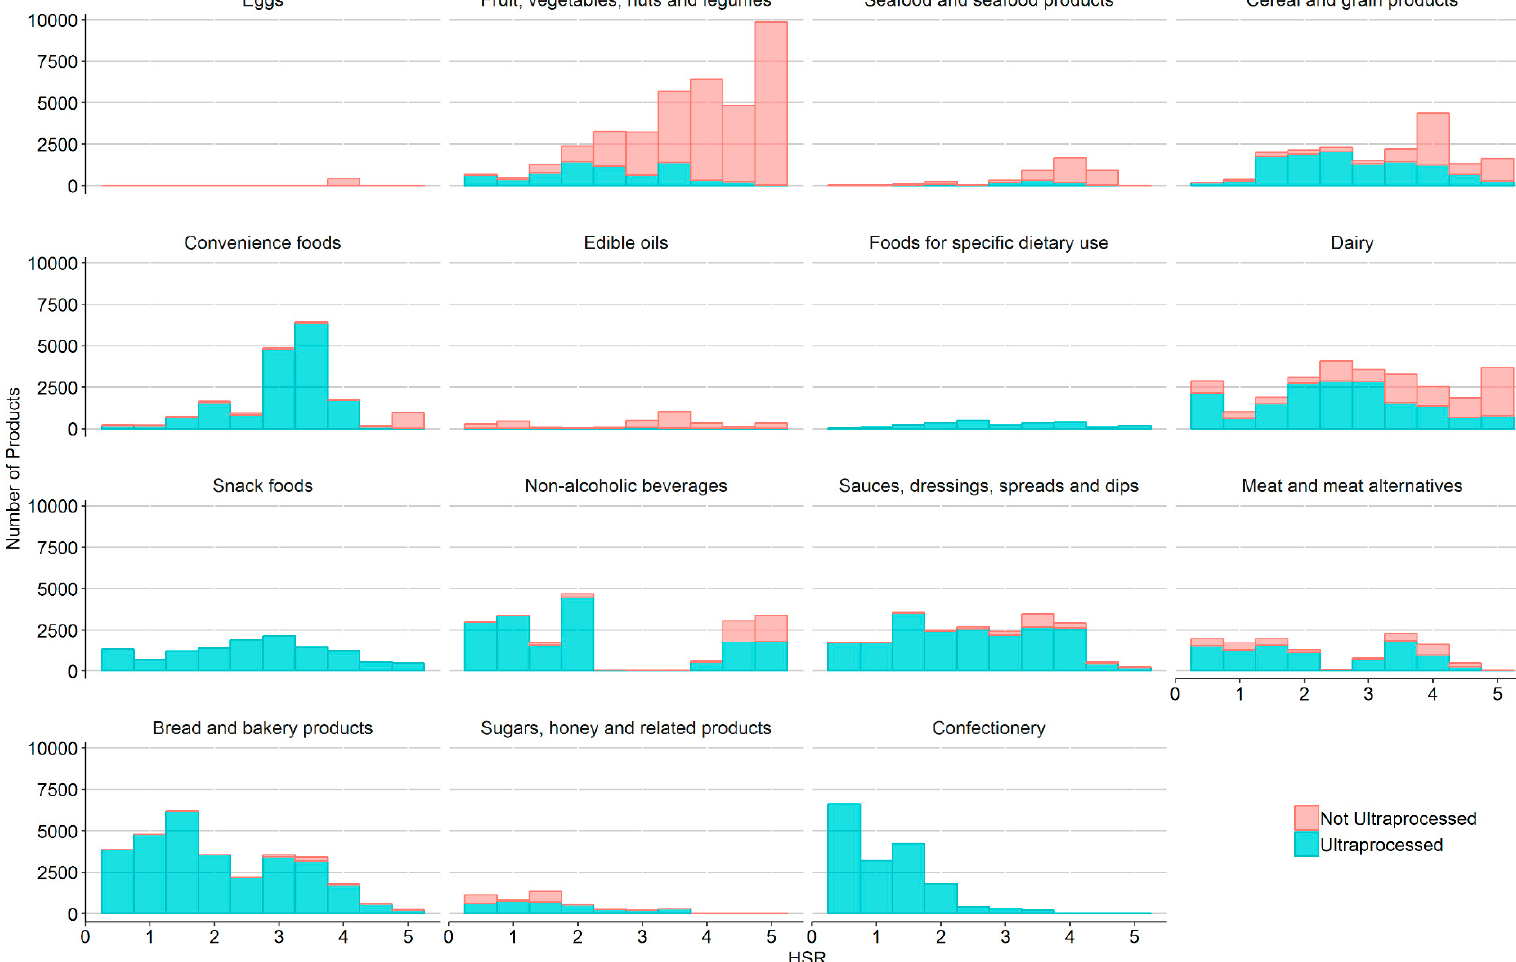
Figure 1. Distribution of Health Star Ratings (HSRs) by major food category for foods that were (blue) and were not (pink) ultra-processed.